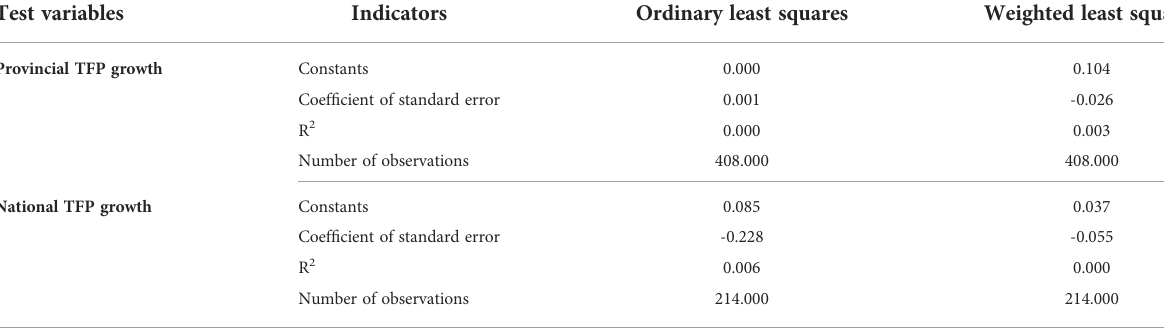
TABLE 5 Results of publication bias test estimated by the OLS and WLS